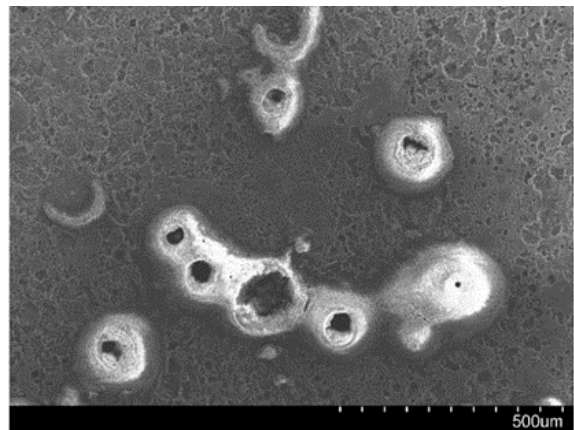
Figure 8. SEM images of hemisphere domes appeared on WE43.